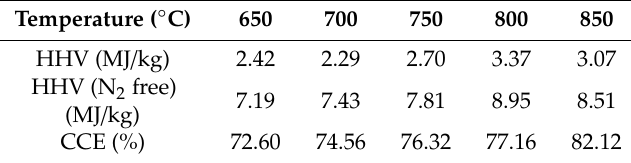
Table 6. E ff ects of temperature on HHV and